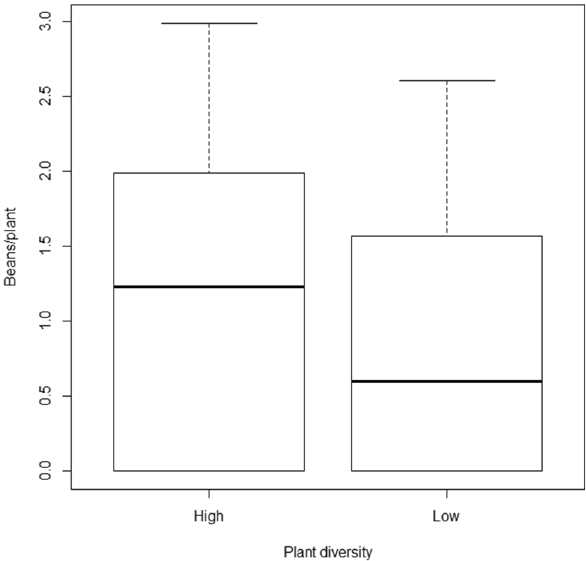
Figure 3. Yield (beans/plant) for the sites in Malawi, categorised according to plant diversity (low = no margin and mean of one or fewer tree species recorded on the transect; high = at least one non-crop vegetated edge to field, mean of 2 or more tree species on the transect). Error bars indicate 1.5*IQR. Created in R 29 version